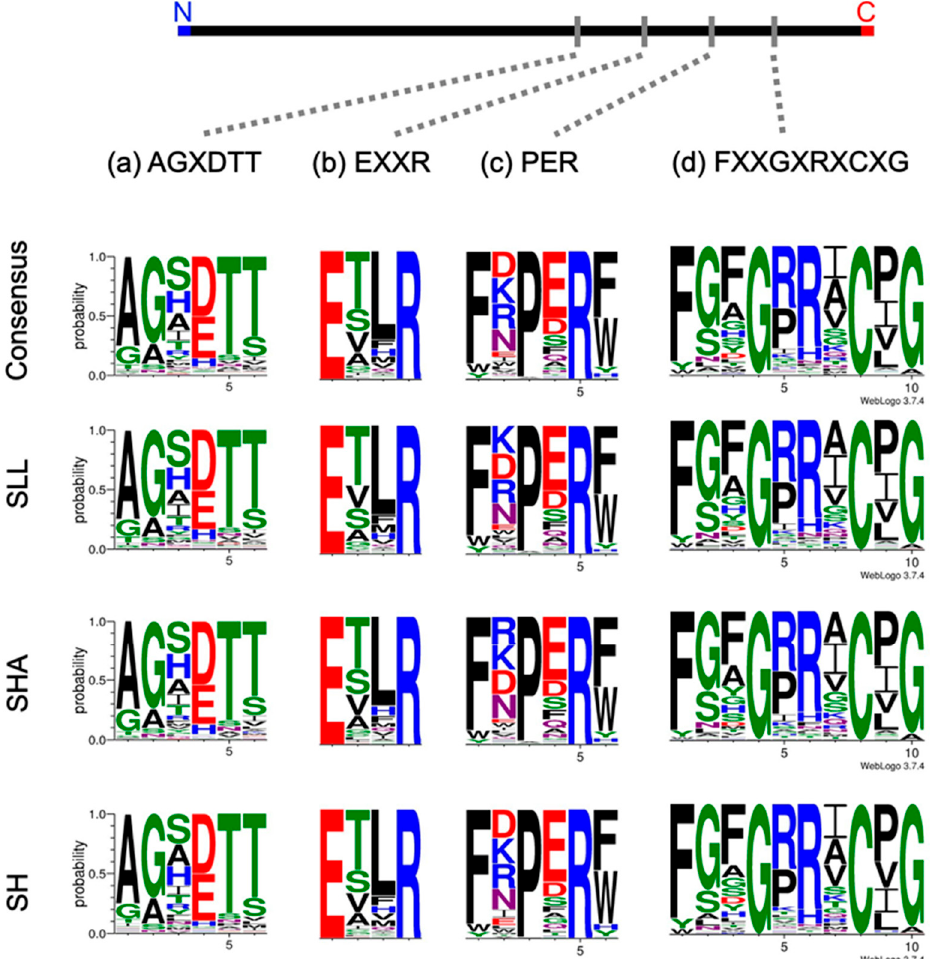
Figure 2. Comparison of the structurally important P450 motifs across the three strains ( S. lacrymans var. lacrymans (SLL), S. lacrymans var. shastensis (SHA) and S. himantioides (SH)) and as a consensus sequence. Relative position of the key structural P450 motifs in the primary sequence is shown at the top with WebLogo [18] probability matrices for those motifs from the three strains are shown below. ( a ) occurs in the I helix, ( b ) occurs in the K helix and together with ( c ) forms the E-R-R triad, and ( d ) is the haem-binding site. The size of the letter is proportionate to the probability of this amino acid occurring in this position. Colour denotes the properties of the amino acid residue—acidic in red, basic in blue, polar in green, hydrophobic in black and neutral in purple.